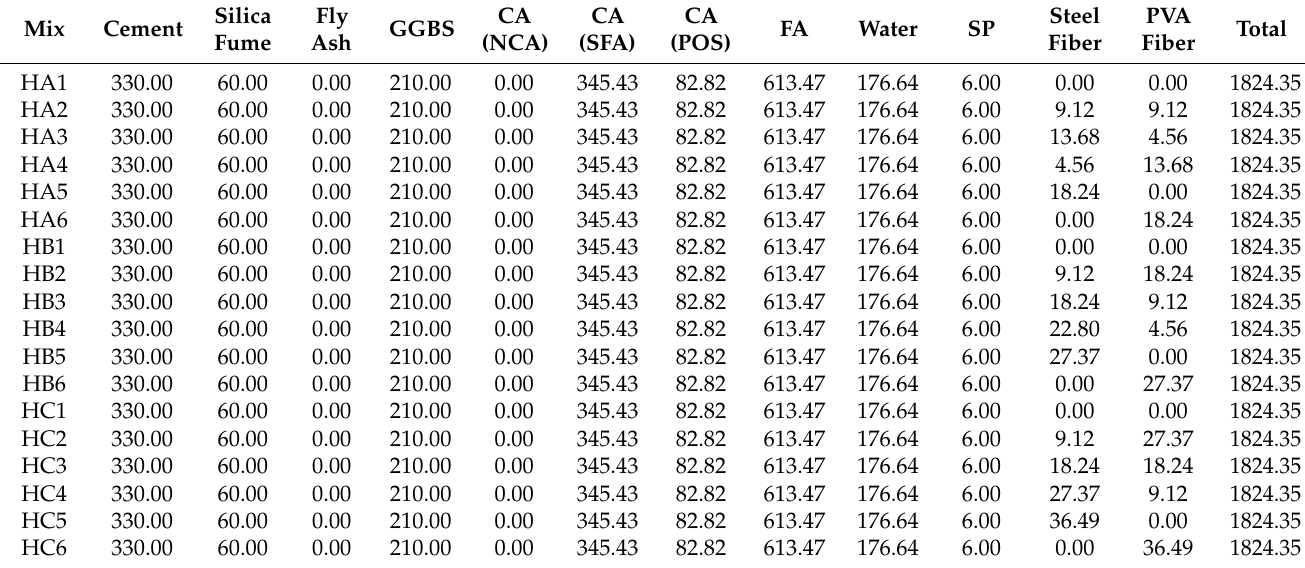
Table 2. Mix design of hybrid fiber-reinforced concrete (kg/m 3 ).